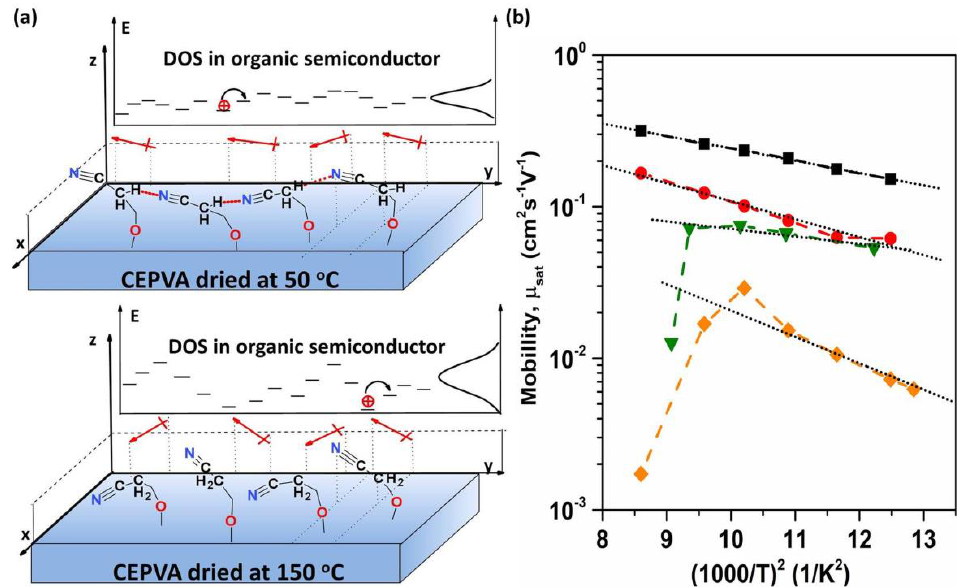
Figure 6. ( a ) Schematic representation of the CEPVA surface dipoles orientation in the z direction (perpendicular to the dielectric surface) after different drying regimes, and its impact on the DOS of the adjacent semiconductor layer. ( b ) Hole mobility µ sat against square of reciprocal temperature for OFETs with various gate dielectrics. black — PVPCL, red — PVP50, green — CEPVA50, orange — CEPVA150.